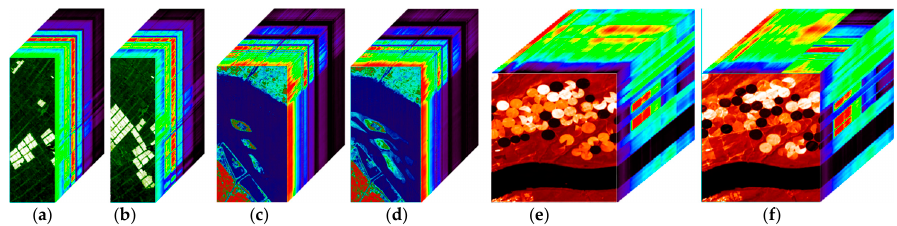
Figure 3. Experimental data sets: ( a ) Farmland data set on 3 May 2006. ( b ) Farmland data set on 21 April 2006. ( c ) River data set on 3 May 2013. ( d ) River data set on 31 December 2013. ( e ) USA data set on 1 May 2004. ( f ) USA data set on 8 May 2007.